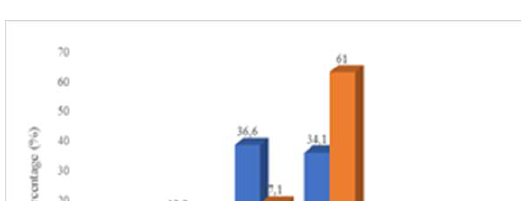
Figure 1. Characteristics of Sedation Scale for Critically Ill Patients on Critical patients in Intensive Care Unit (n=41)